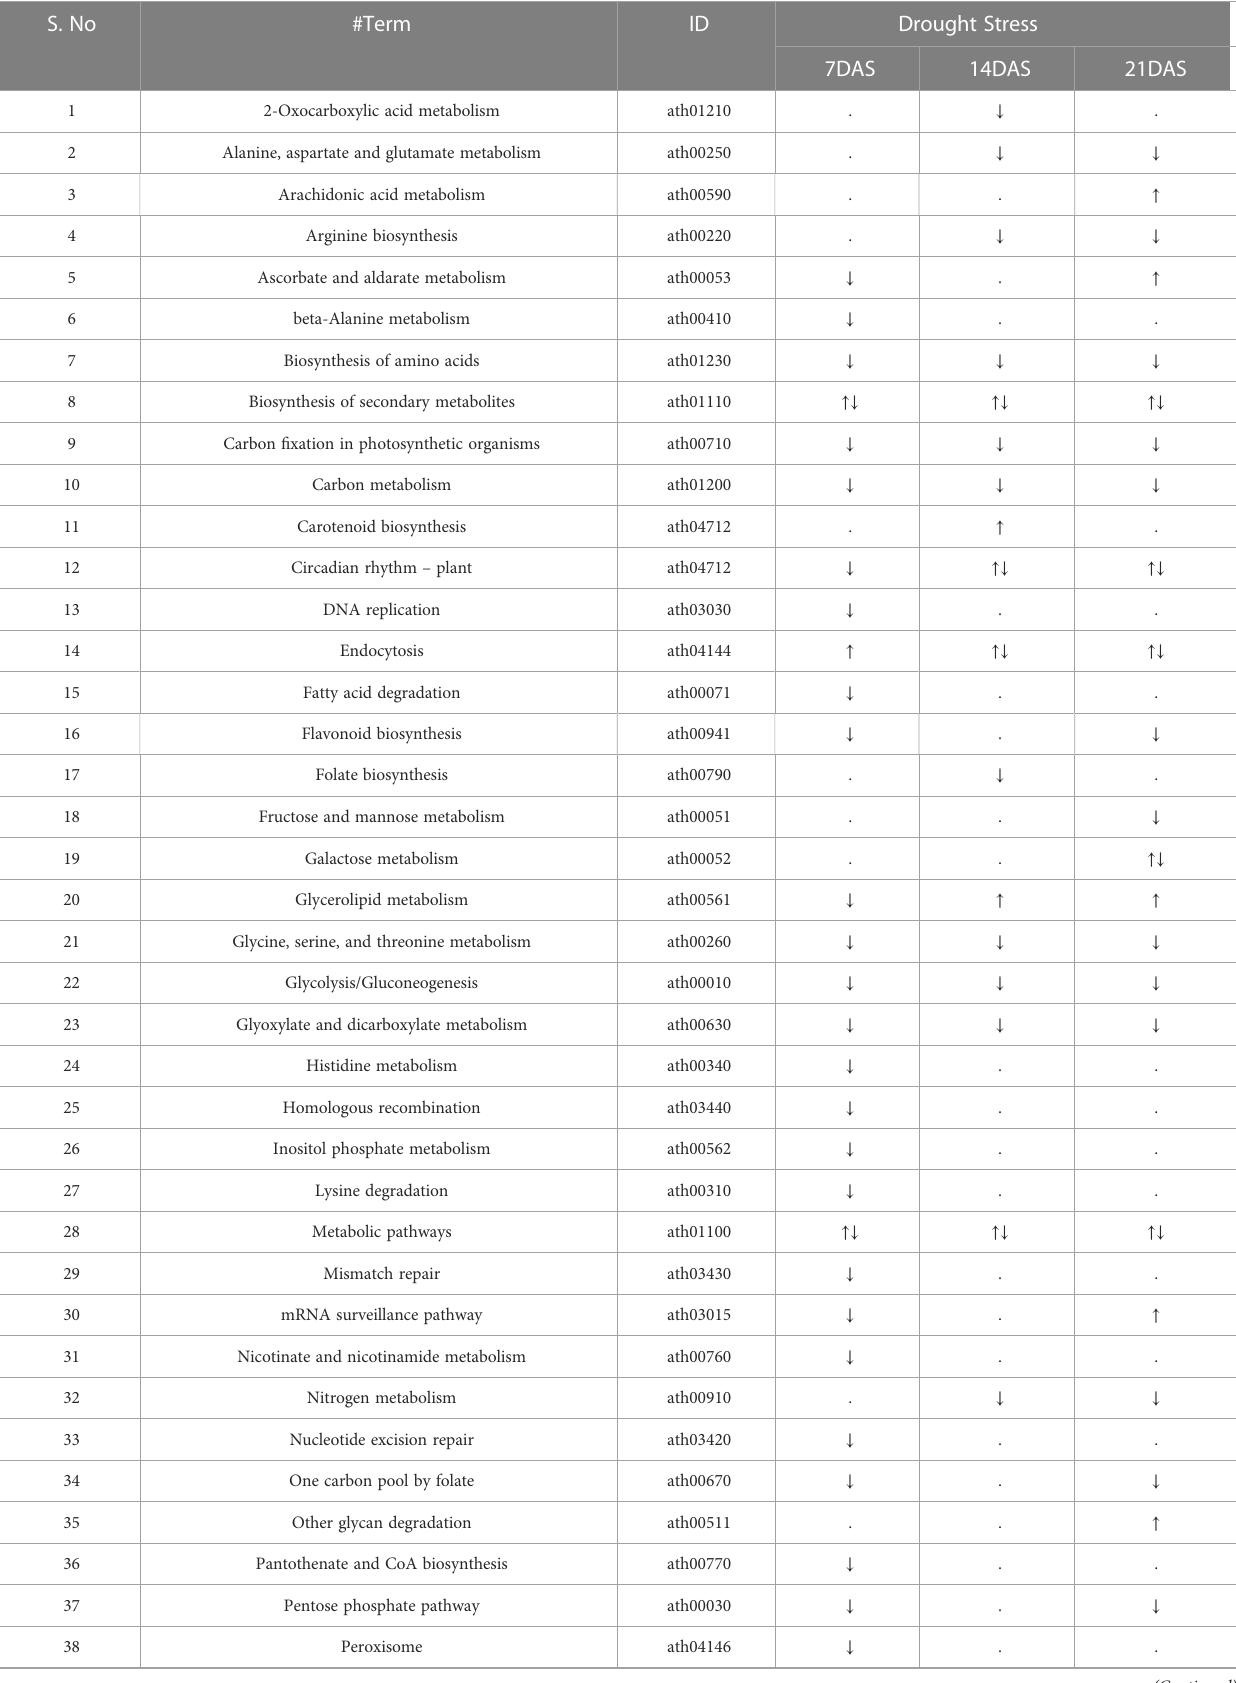
TABLE 3 KEGG pathway enrichment analysis of differentially expressed genes in response to drought stress in sugar